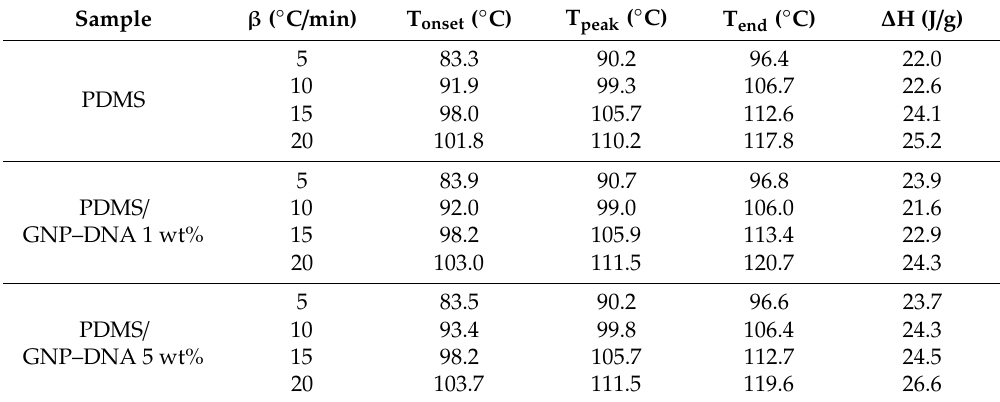
Table 1. Curing process parameters for PDMS (Sylgard 184) and its nanocomposites with GNP–DNA filler from DSC dynamic scans at di ff erent heating rates.